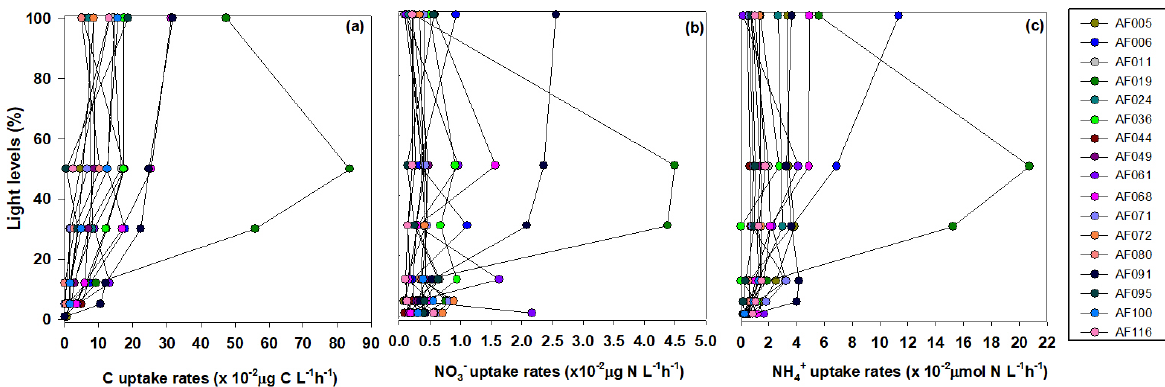
Figure 2. Depth-wise small phytoplankton uptake rates of C, NO −